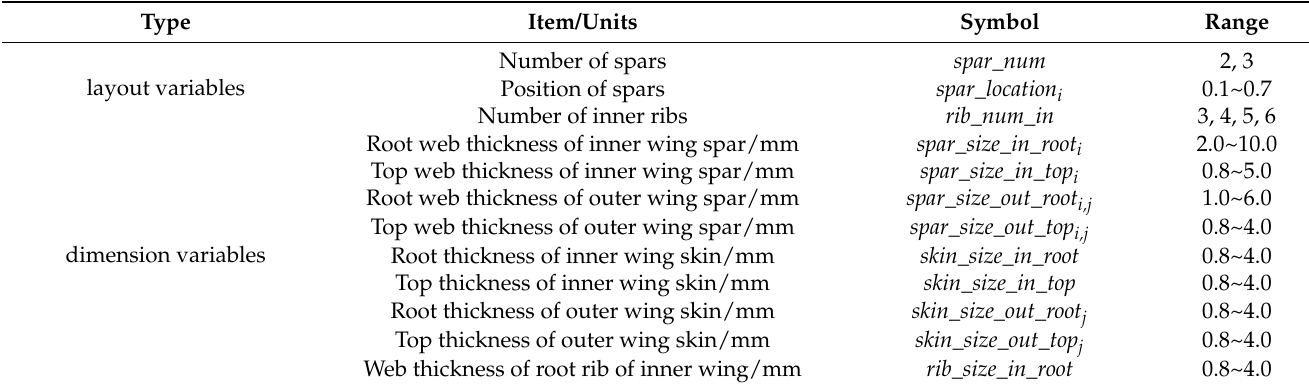
Table 5. Symbols and value ranges of